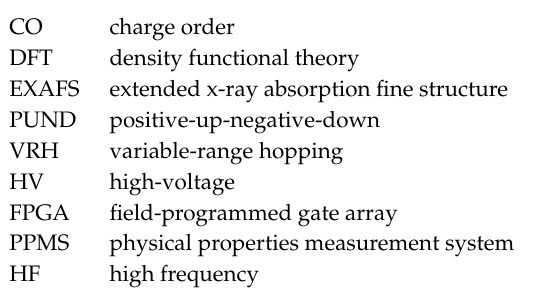
Figure S1: rocking curves, Table S1: domains and calculated intensities, supplementary